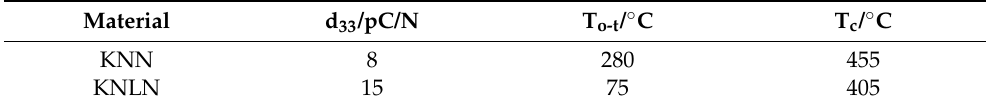
Figure 7. Dielectric temperature spectra of KNN and KNLN coatings. (1 KHz). ( a ) Dielectric constant and ( b ) Dielectric loss. Table 3. Piezoelectric coefficient of KNN coating and KNLN coating.